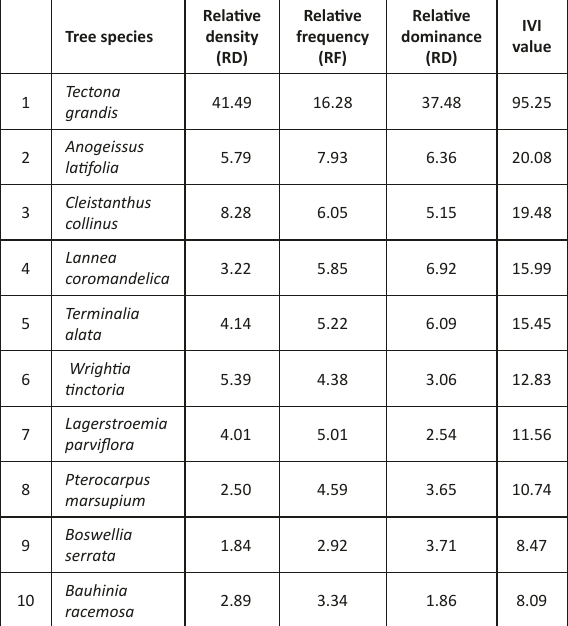
Table 3. Ecological dominance of tree species (above 30cm GBH) based on IVI values. Tree